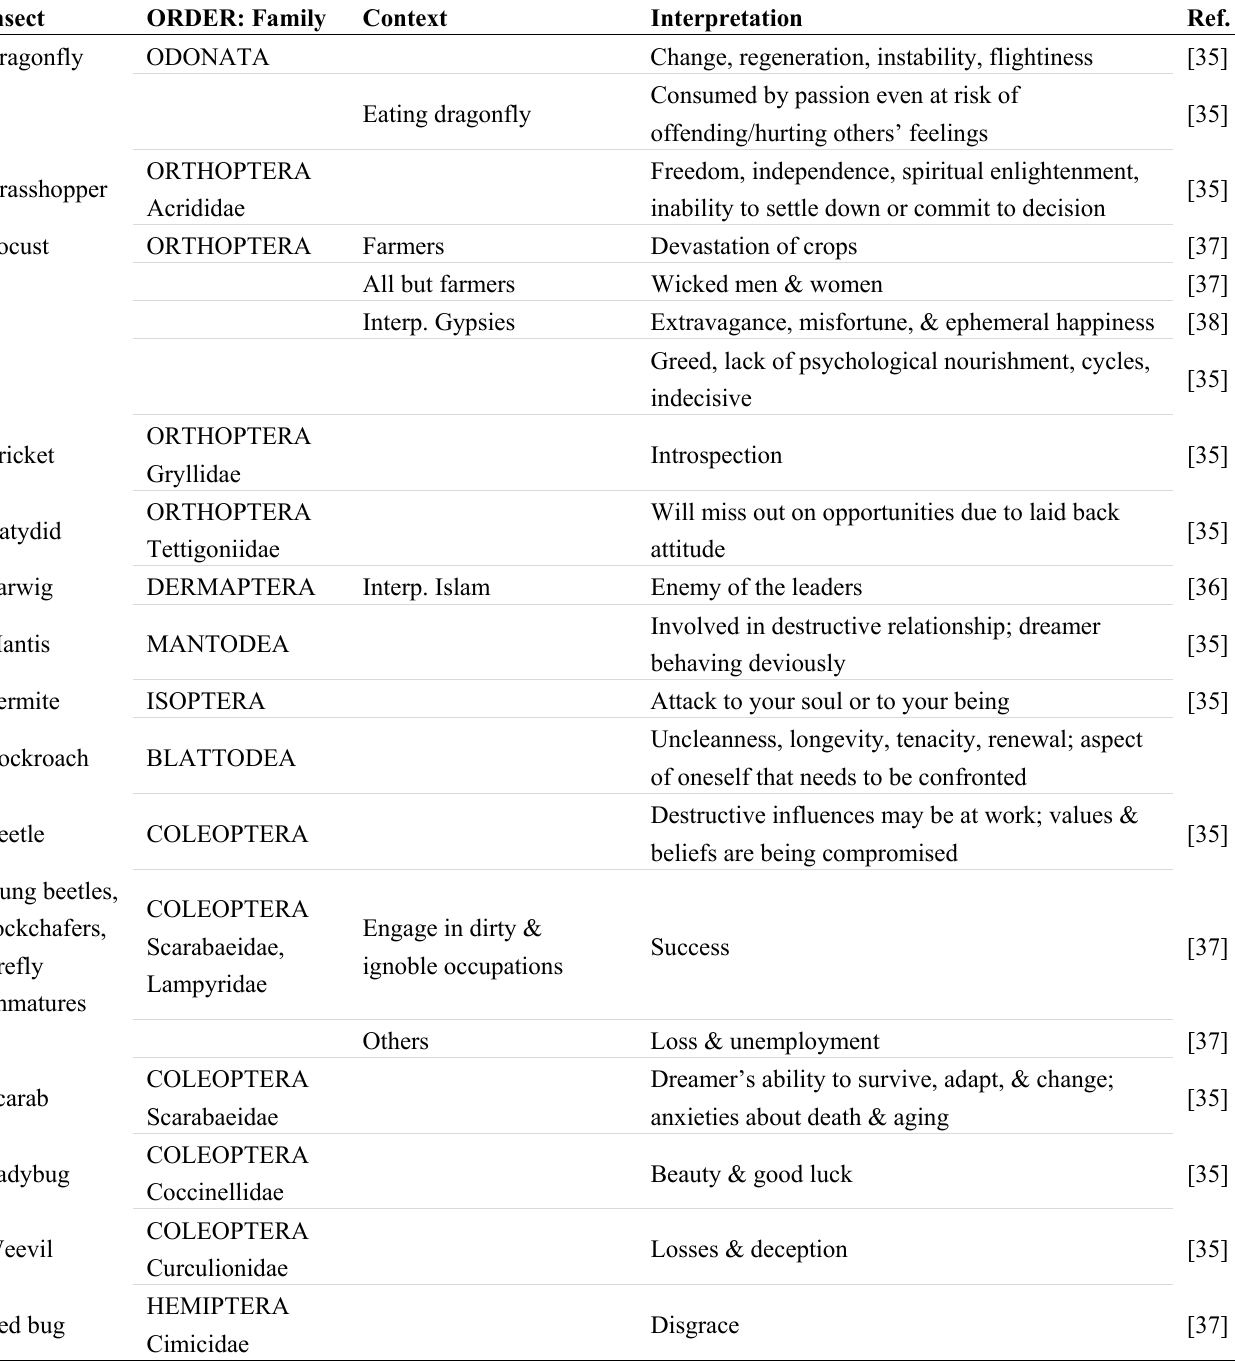
Table 1. Sample of dream interpretations that feature insects, organized by the insects’ common names as they were written in the dream interpretations, what I assume to be their Order and Family affiliations, and the context within which the interpretations were made (e.g., Islamic interpretation of dream in which the dreamer was bitten by a flea). The source for each dream interpretation is indicated by the reference number to the right of each